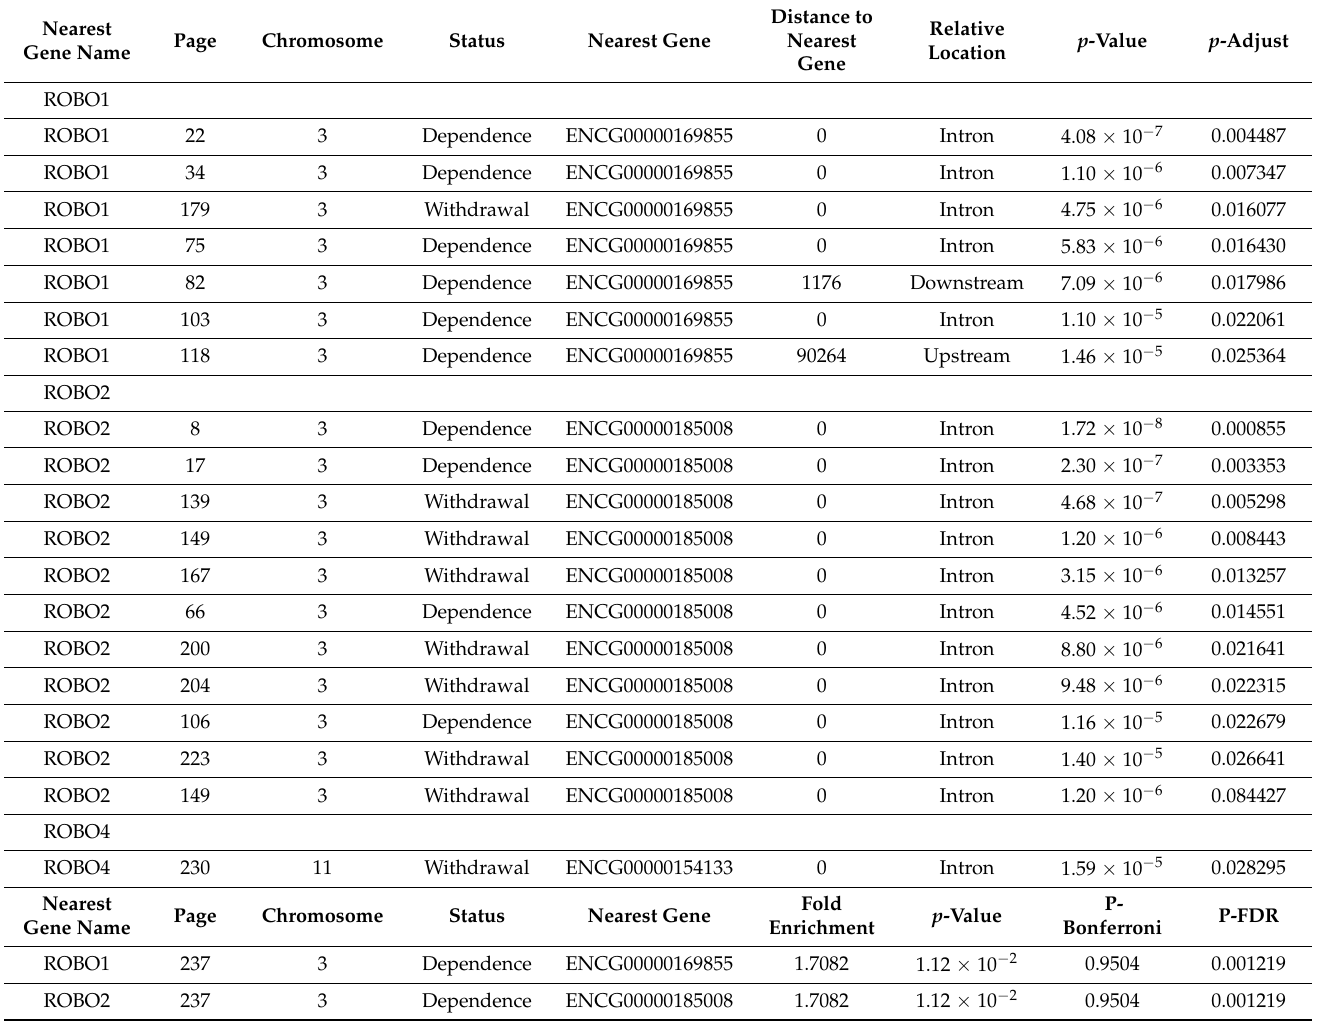
Table 10. Epigenomic Data for Robo EWAS Hits, Data from Schrott